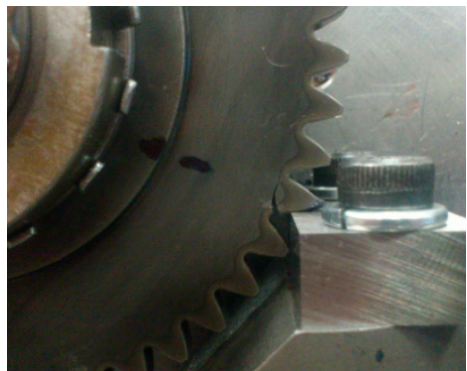
Figure 6. Fatigue test on hardened gear.